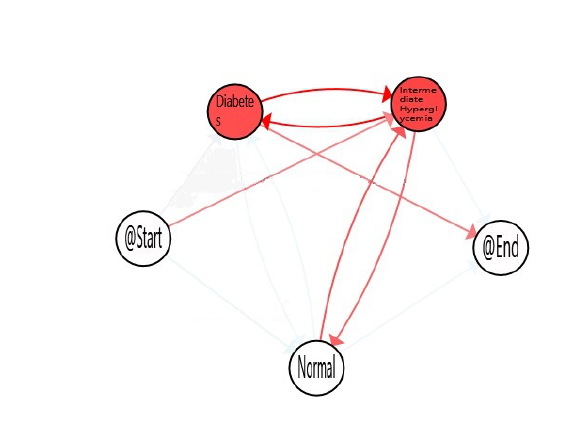
Figure 10. Difference enhancement model: Adult-Elderly.